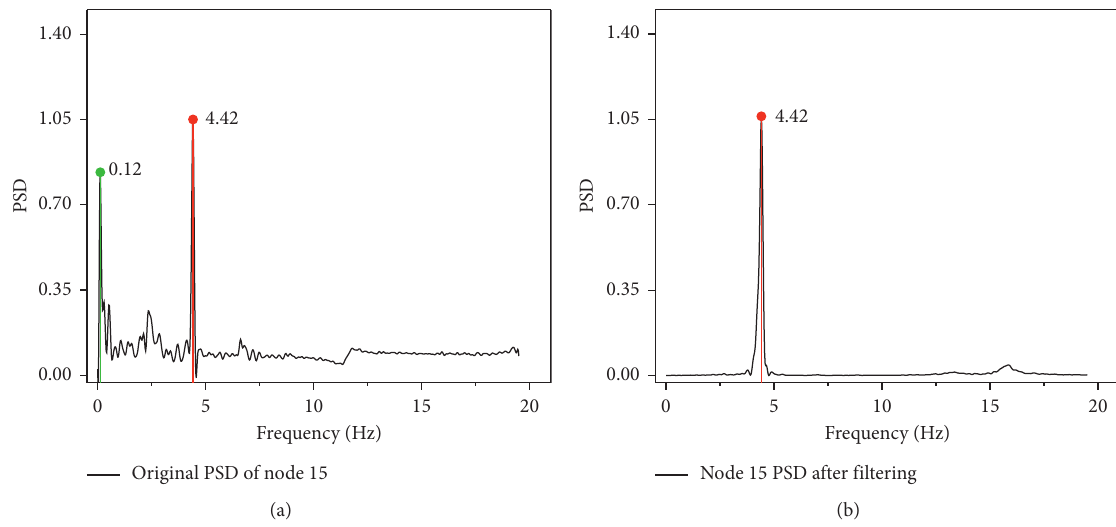
Figure 13: The frequency identification result of the differential filter. (a) PSD at the ending point. (b) PSD at the ending point after